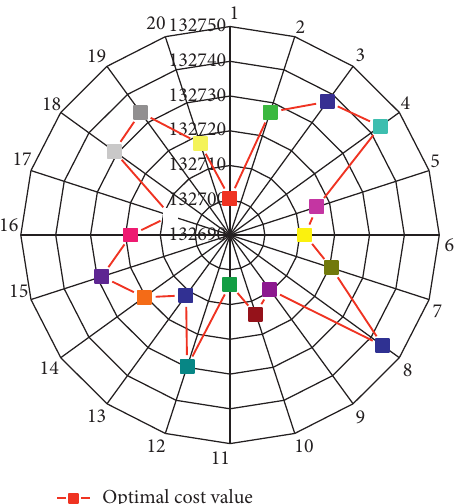
Figure 7: Optimal cost values for independent